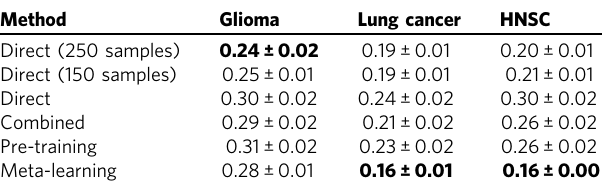
Fig. 3 C-Index for target cancer survival prediction, comparing combined learning, regular pre-training and meta-learning. The fi gure shows results for lung cancer (top panel), glioma (middle panel) and head and neck cancer (bottom panel). Table 2 Integrated Brier scores (IBS) with 95% con fi dence intervals ( n = 25 trials) for target cancer survival prediction with 20 samples, unless speci fi ed